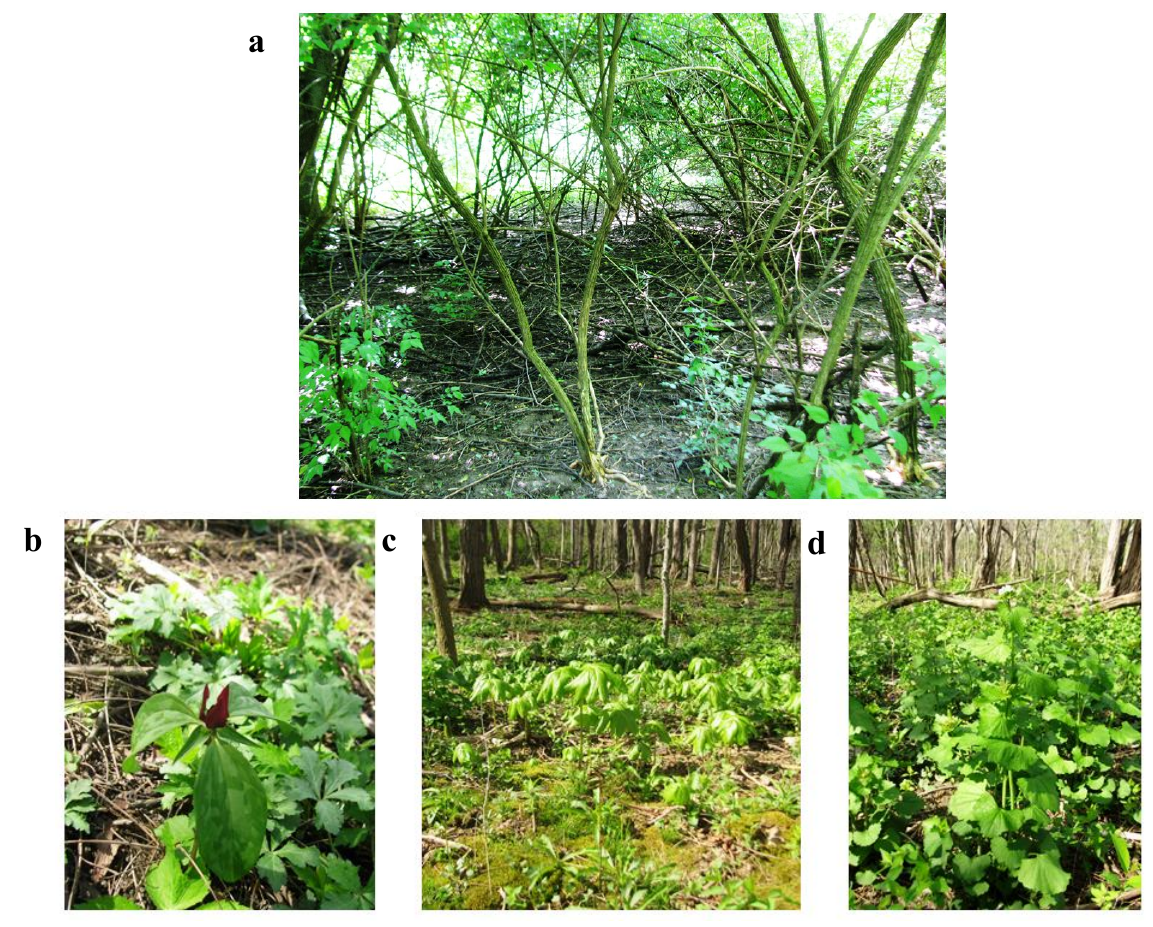
Figure 6. ( a ) Lonicera maackii thicket showing no native plant regeneration on the forest floor; ( b ) Trillium recurvatum (bloody butcher); ( c ) Podophyllum peltatum , and ( d ) Alliaria petiolata displayed positive responses to the removal of non-native shrubs. All photos were taken at Purdue University, Department of Forestry and Natural Resources Farm (FNR Farm), by Michael